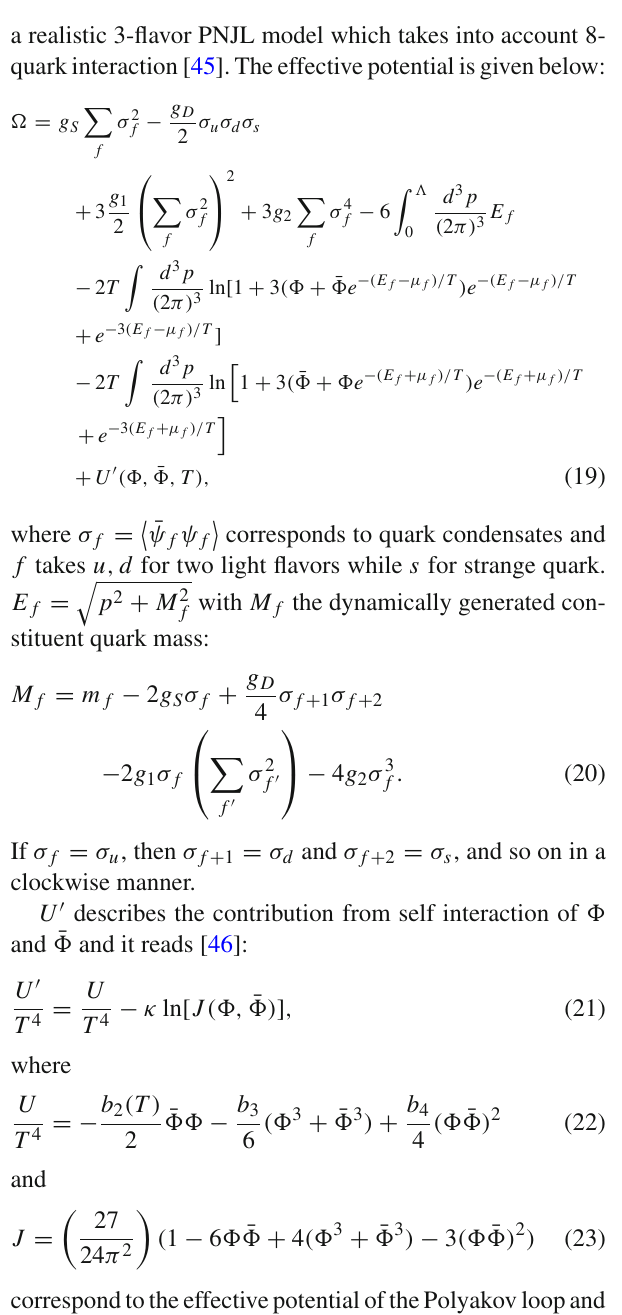
Follow [45], the parameters of the NJL part are fixed by vacuum properties and the parameters of Polyakov loop part are fixed by global fitting of the pressure density at zero chemical potential, and the details are listed in Tables 4 and 5,